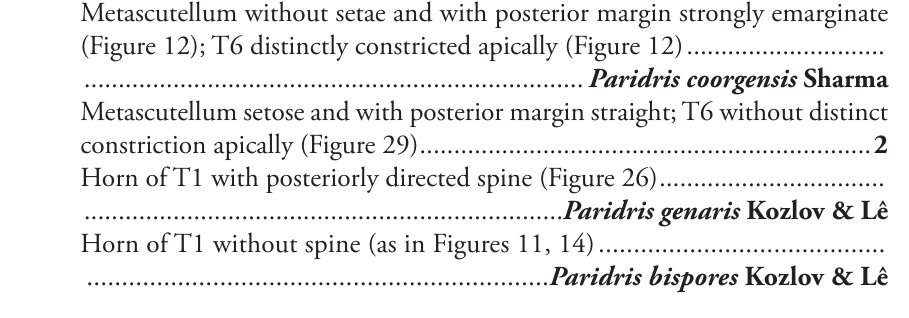
Metascutellum without setae and with posterior margin strongly emarginate (Figure 12); T6 distinctly constricted apically (Figure 12)